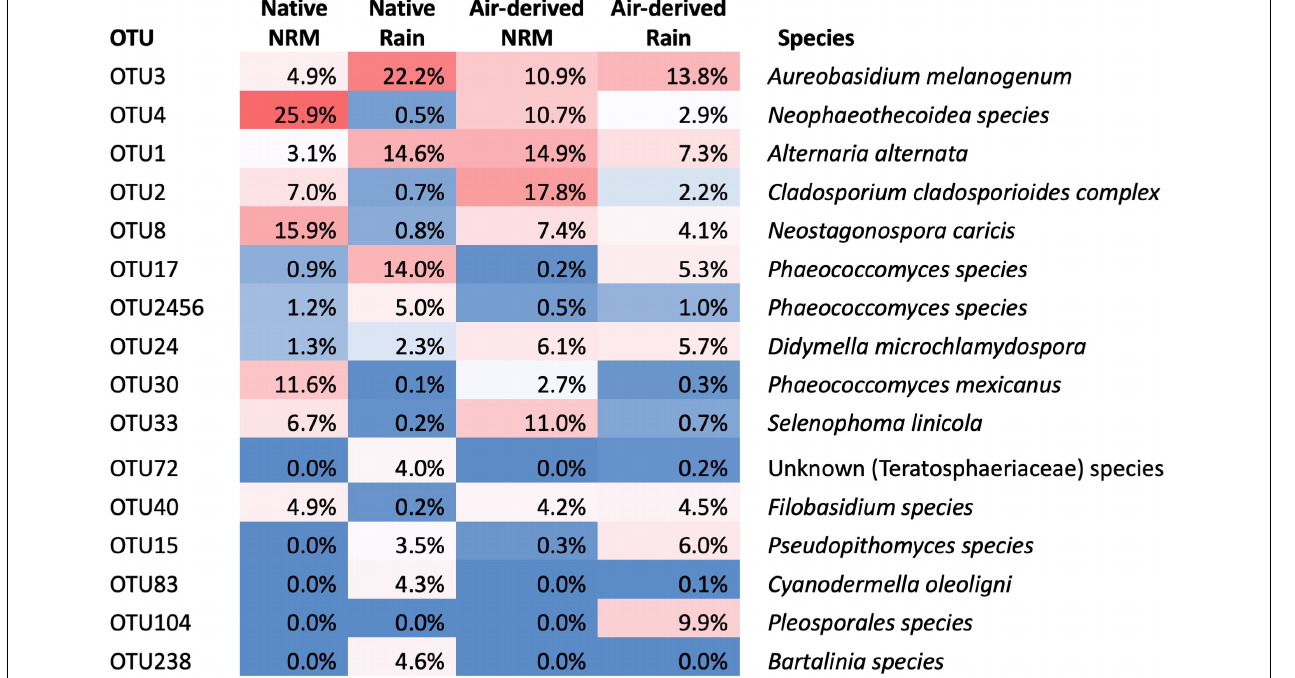
( Figure 3 ): Cladosporium cladosporioides complex